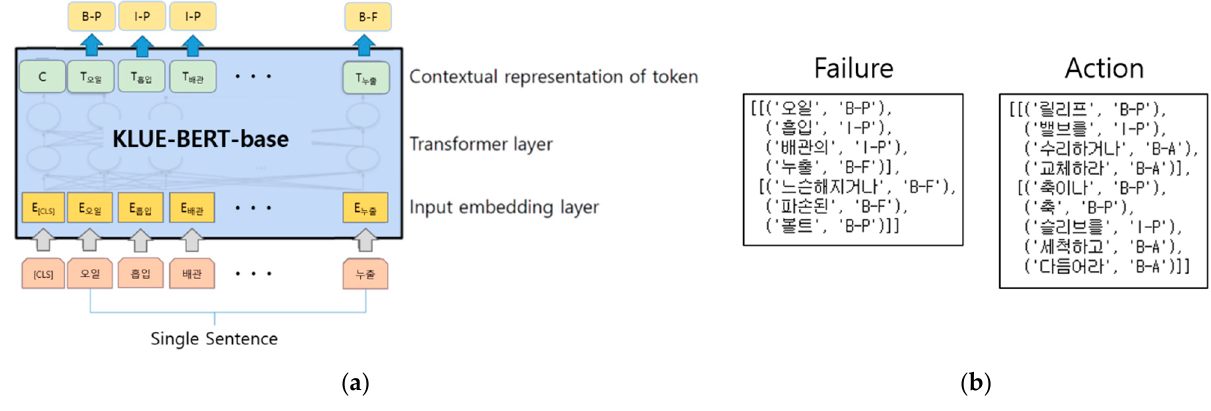
Figure 3. ( a ) NER model structure; ( b ) example of an NER result.